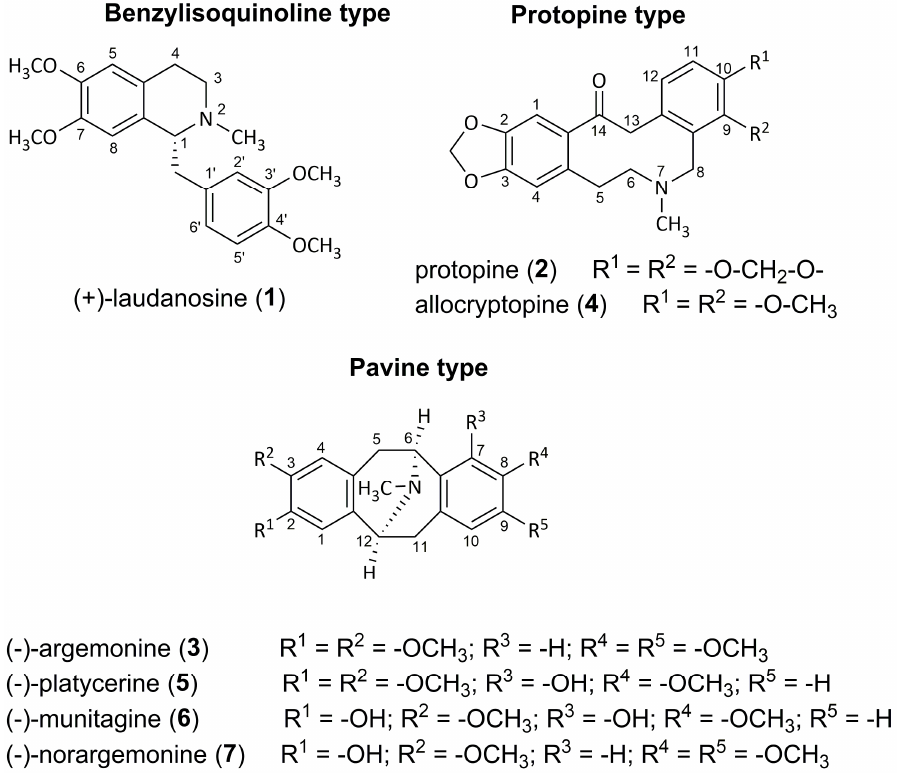
Figure 1. Tertiary alkaloids isolated from A. platyceras in our study.